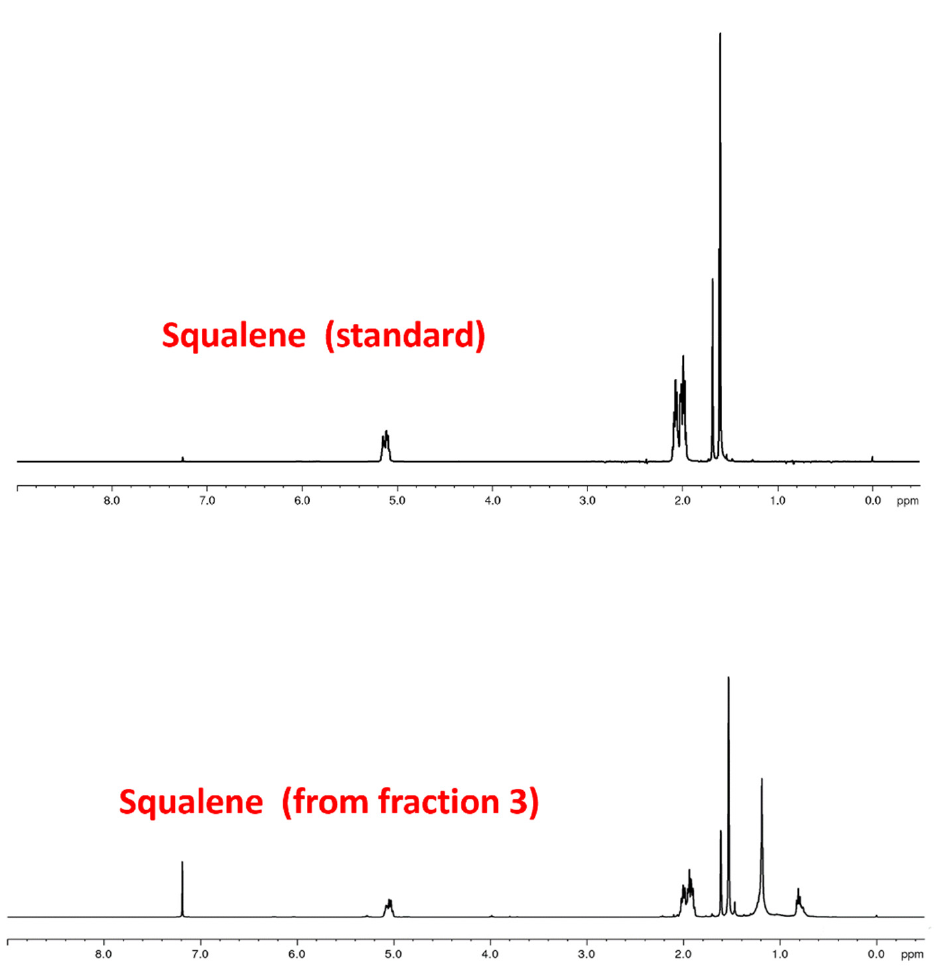
Figure 3. 1 H NMR spectrum of squalene obtained through fraction 3 compared with the 1 H NMR spectrum of pure squalene.